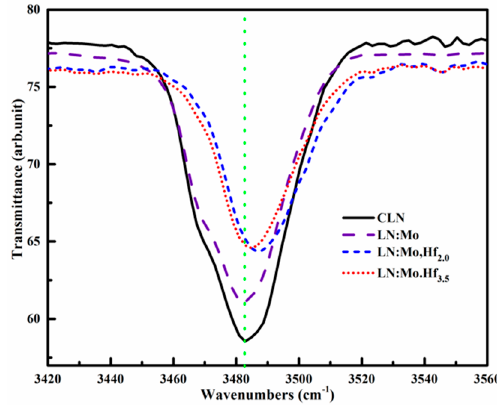
Figure 4. The OH − spectra of LN: Mo, Hf crystals with different concentrations of Hf 4+ . The spectrum of CLN is presented for comparison.